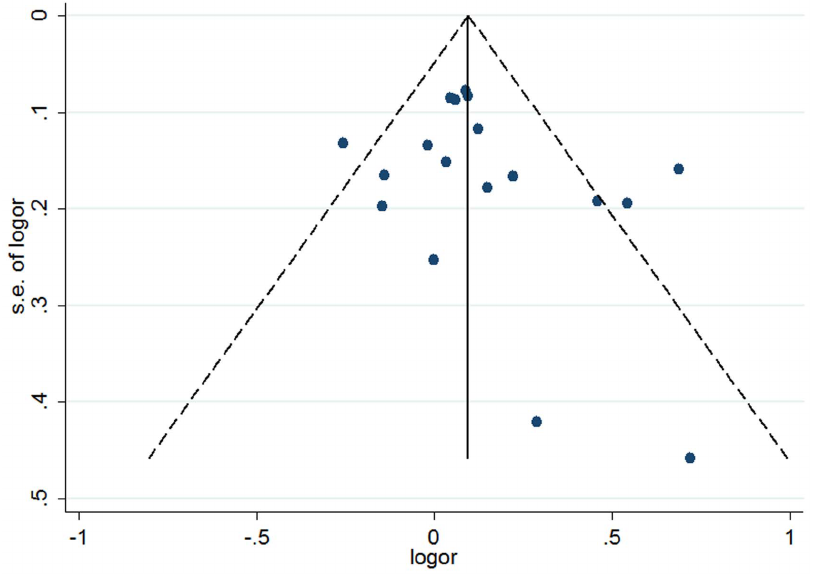
Figure 6. Funnel plot of the association between the XRCC1 Arg399Gln and breast cancer risk for the dominant model.